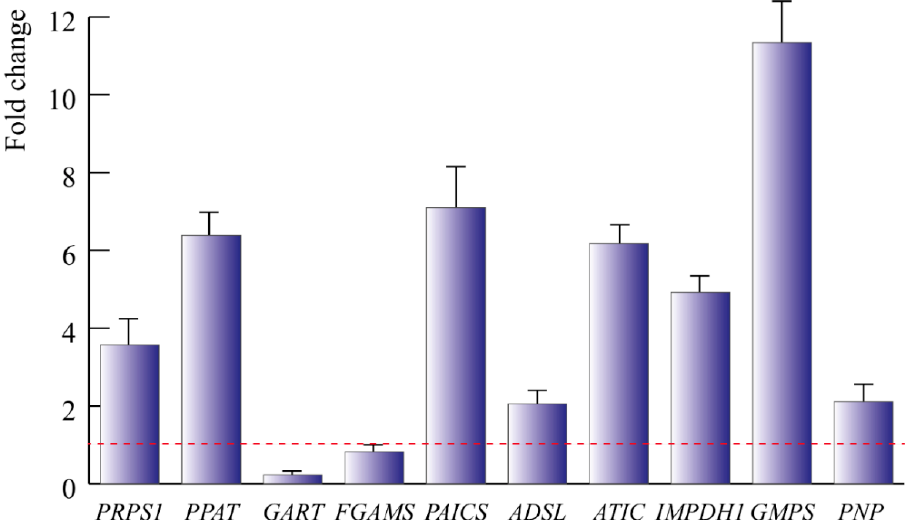
Figure 5. qPCR guanine gene expression of TSSM. Bars indicate the standard deviation over the mean of at least three biological replicates. The red dotted bar represents the reference gene expression; values above the dotted line indicate upregulation.